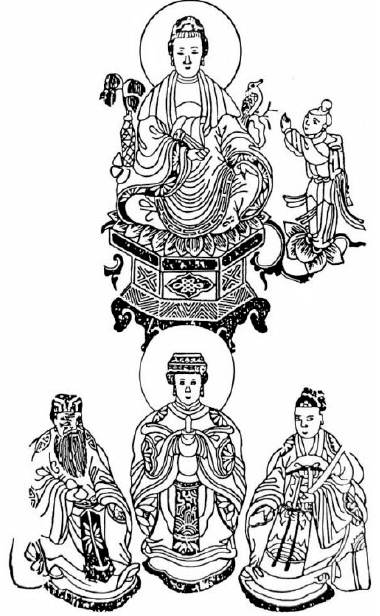
Figure 9. “Guan-yin-ma-lian” collected by Zhang Muyang. Figure 9. “Guan‑yin‑ma‑lian” collected by Zhang